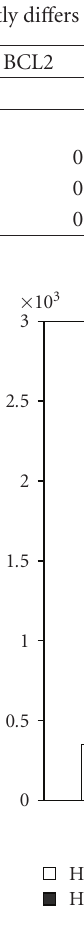
Figure 4: Caspase-3/7 activity. The relative fluorescence (RFLU) emitted upon cleavage of the specific by caspase-3/7 substrate Z- DEVD-R110 was divided to the number of living cells to normalize basal activity. The activity was greater in He-LGI1 cells than in He- pcDNA3 ( n = 6–8; P < .